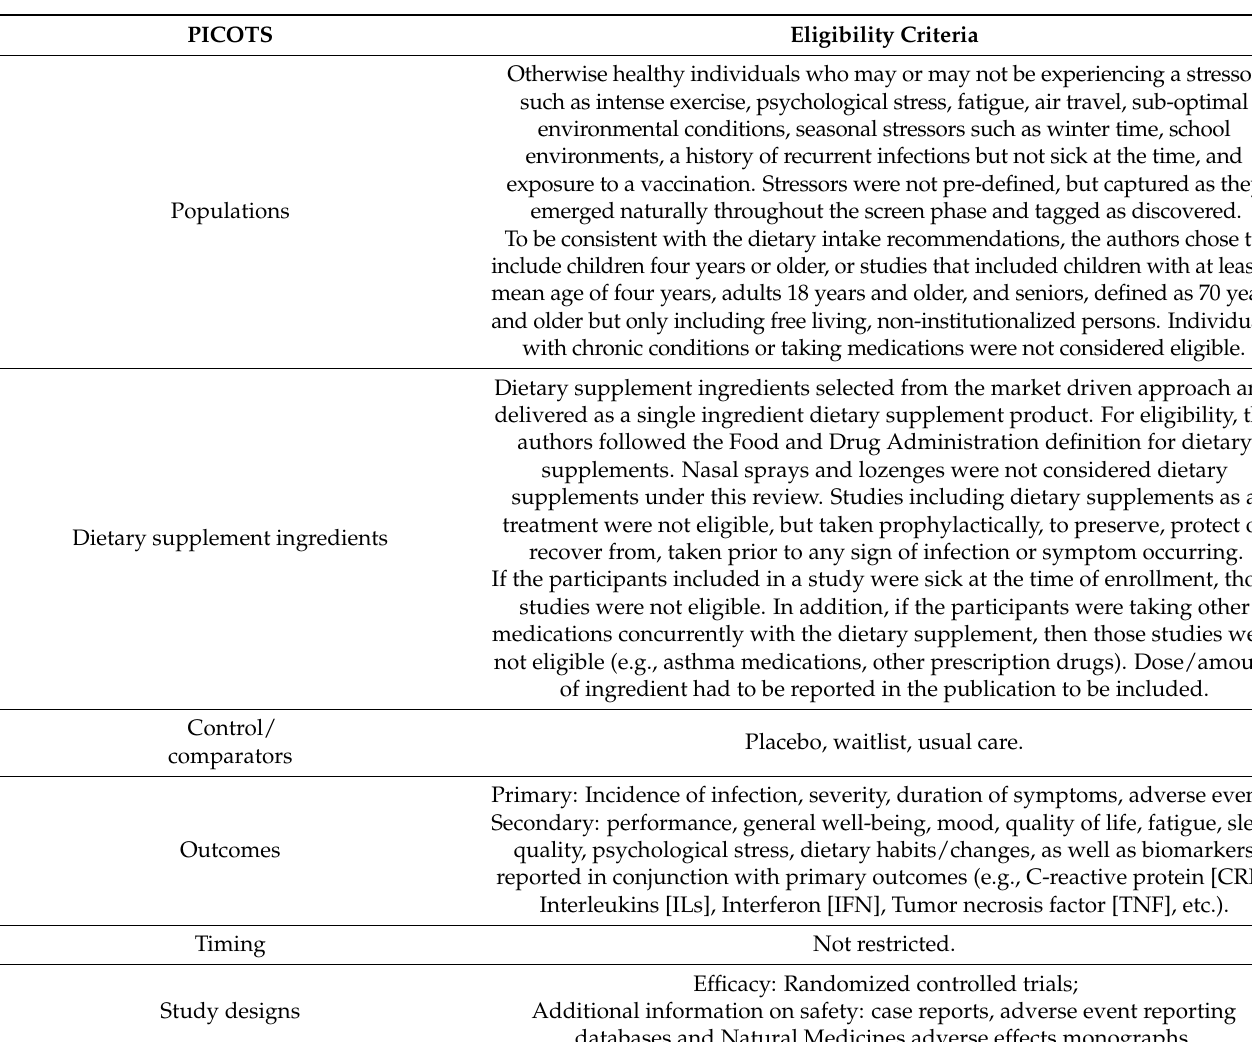
Table 1. Eligibility criteria for systematic